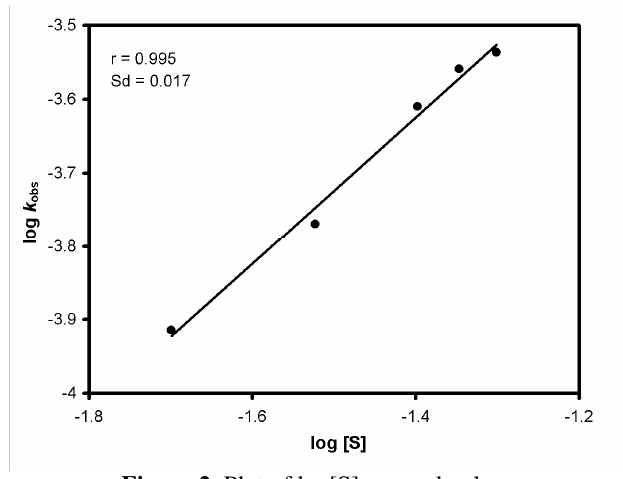
Figure 2 . Plot of log[S] versus log k